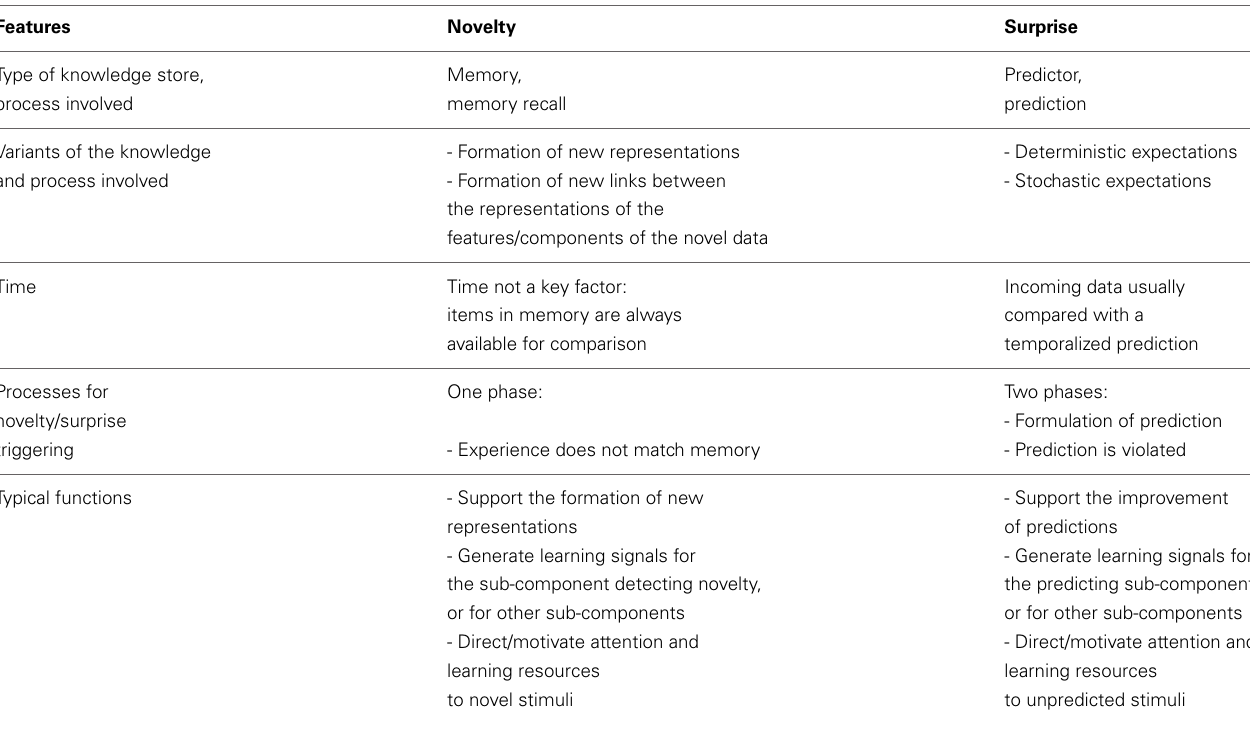
Table 1 | The typical features of novelty and